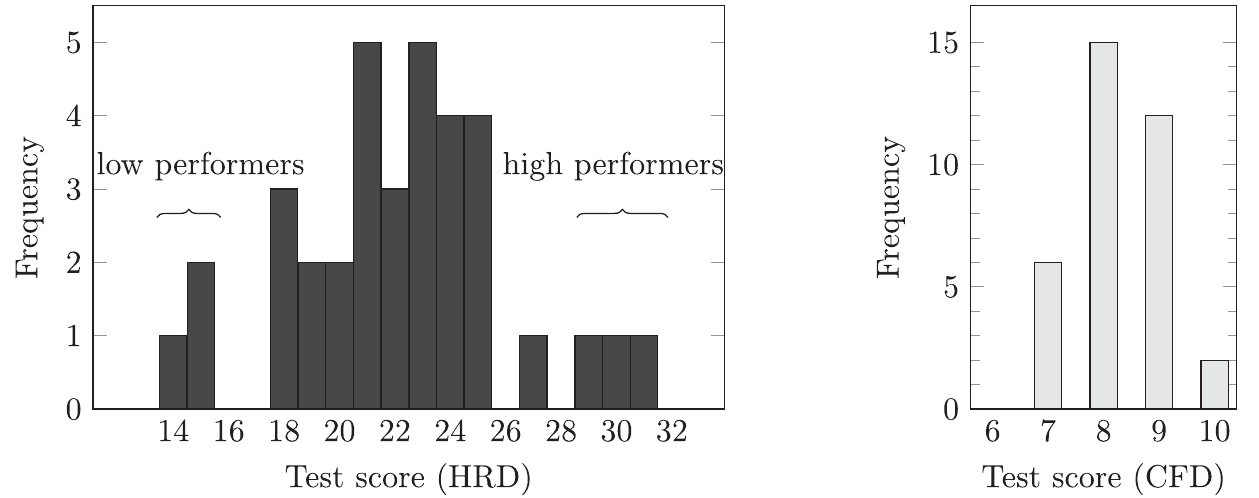
FIG. 5. Histograms of the achieved test scores for the HRD items (left, maximum score 32) and the CFD items using an x - y diagram (right, maximum score 10). Scores lower than 13 (HRD) and 6 (CFD) were not found for the items and are therefore not shown for clarity. The three students with the lowest and highest HRD scores are designated as extreme performance groups